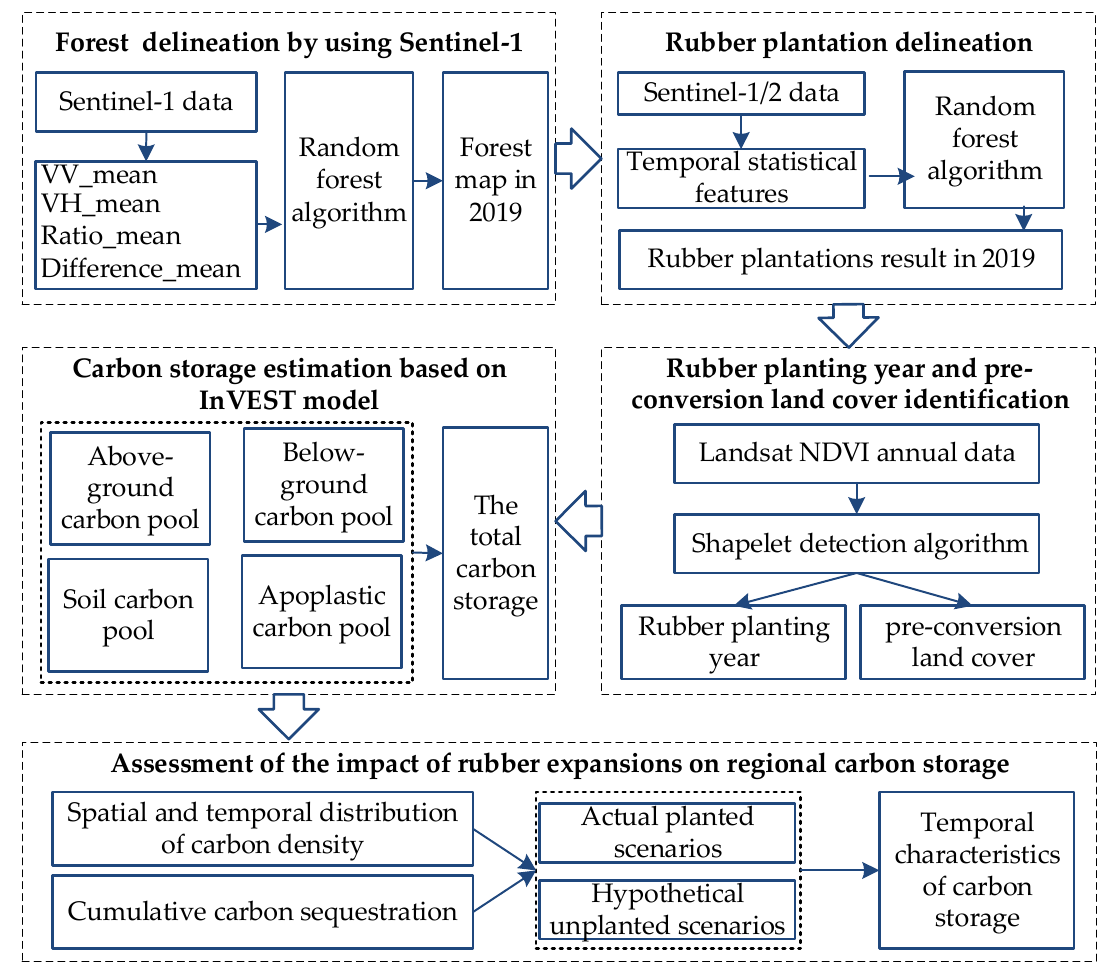
Figure 2. Workflow of the method adopted for this study to assess the impact of rubber expansions on regional carbon storage.